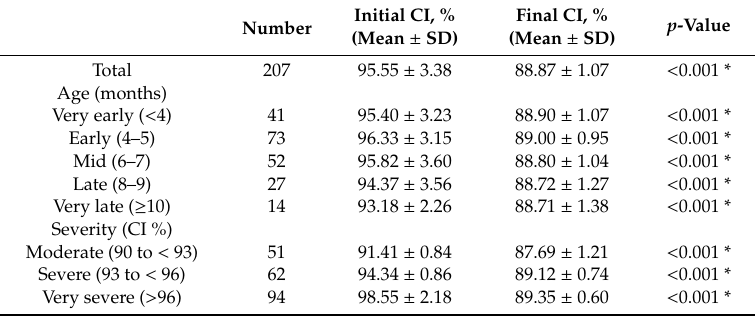
Table 3. E ff ects of helmet therapy according to age at treatment initiation and severity of brachycephaly (paired t-test).